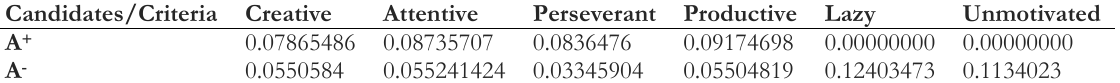
Table 11. The results of the best alternative (A + ) and the worst alternative (A -